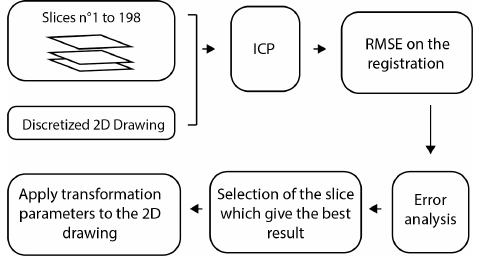
Figure 3. Processing chain for the registration of the architectural drawing with the point cloud.